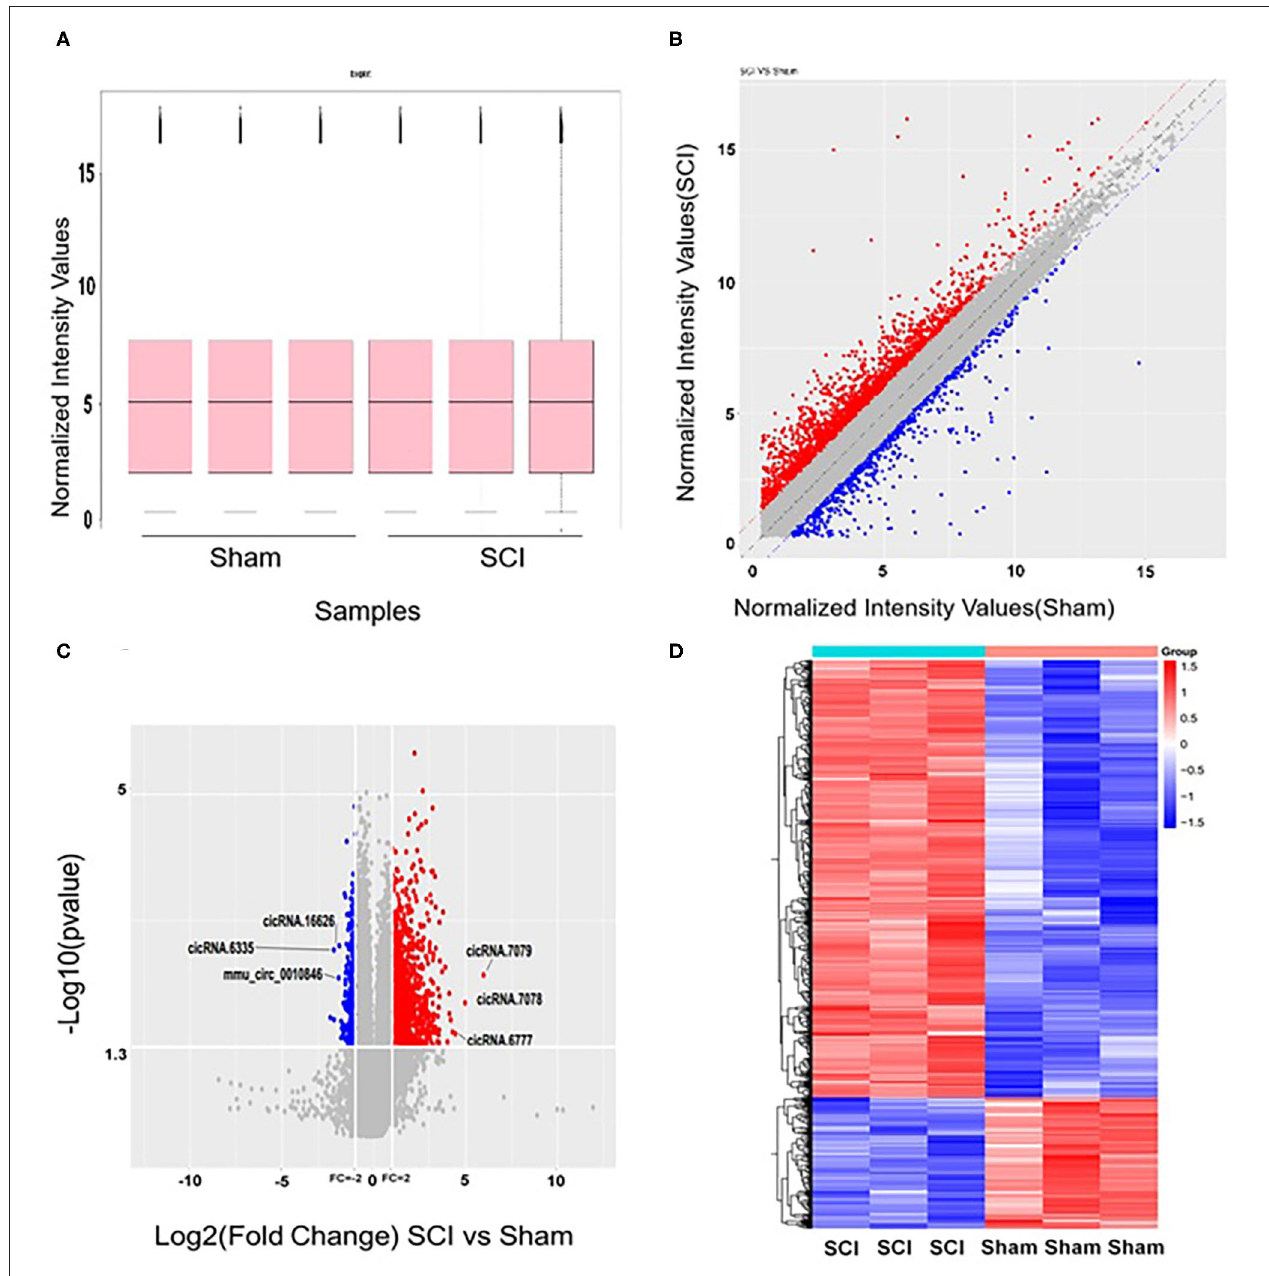
FIGURE 1 | Altered expression profiles of circRNAs in the spinal cord after spinal cord injury (SCI). (A) No significant differences were observed in the distributions of the total expression of circRNAs between the two groups. (B) The oblique lines are fold change lines. The circRNAs above the top red line and below the bottom blue line indicate a > 2-fold change of circRNAs between the two groups. (C) Volcano plot shows circRNAs altered in the SCI group compared with sham. (D) Differences in circRNA expression. Heat map presenting the circRNA expression profiles; each column represents a sample and each row represents a gene. High relative expression is indicated by red, and low relative expression by